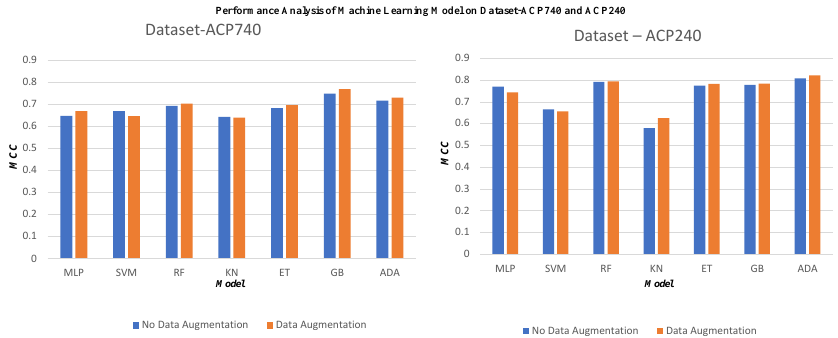
Figure 3. Comparison of the prediction models with and without data augmentation on the ACP740 and ACP240